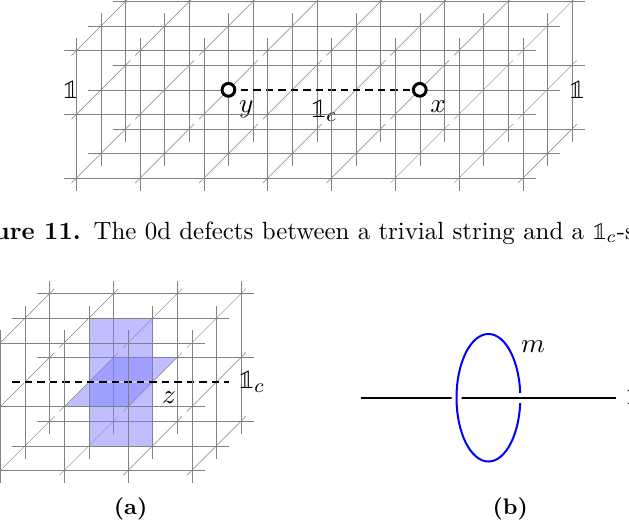
Figure 12. (a): the microscopic realization of the nontrivial 0d defect between two 1 c -strings; (b): this 0d defect can be obtained by shrinking an m -loop winding around a 1 c